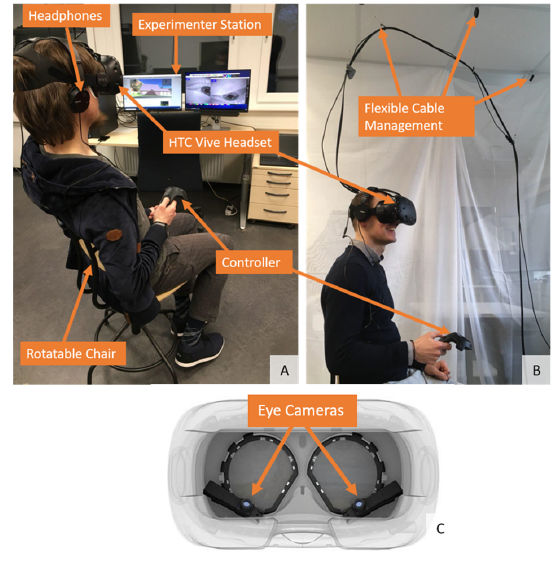
Figure 1: Our HTC Vive setup. (A) Participant sitting in a swivel chair during a session. Walking in the virtual world is done with the controller in our experiment. (B) The flexible cable manage- ment system keeps the cables from tangling up and getting in the way of the subject during the session. (C) Pupil Labs Eye-Tracker inside the HTC Vive Headset. Image source: https://pupil- labs.com/vr-ar/